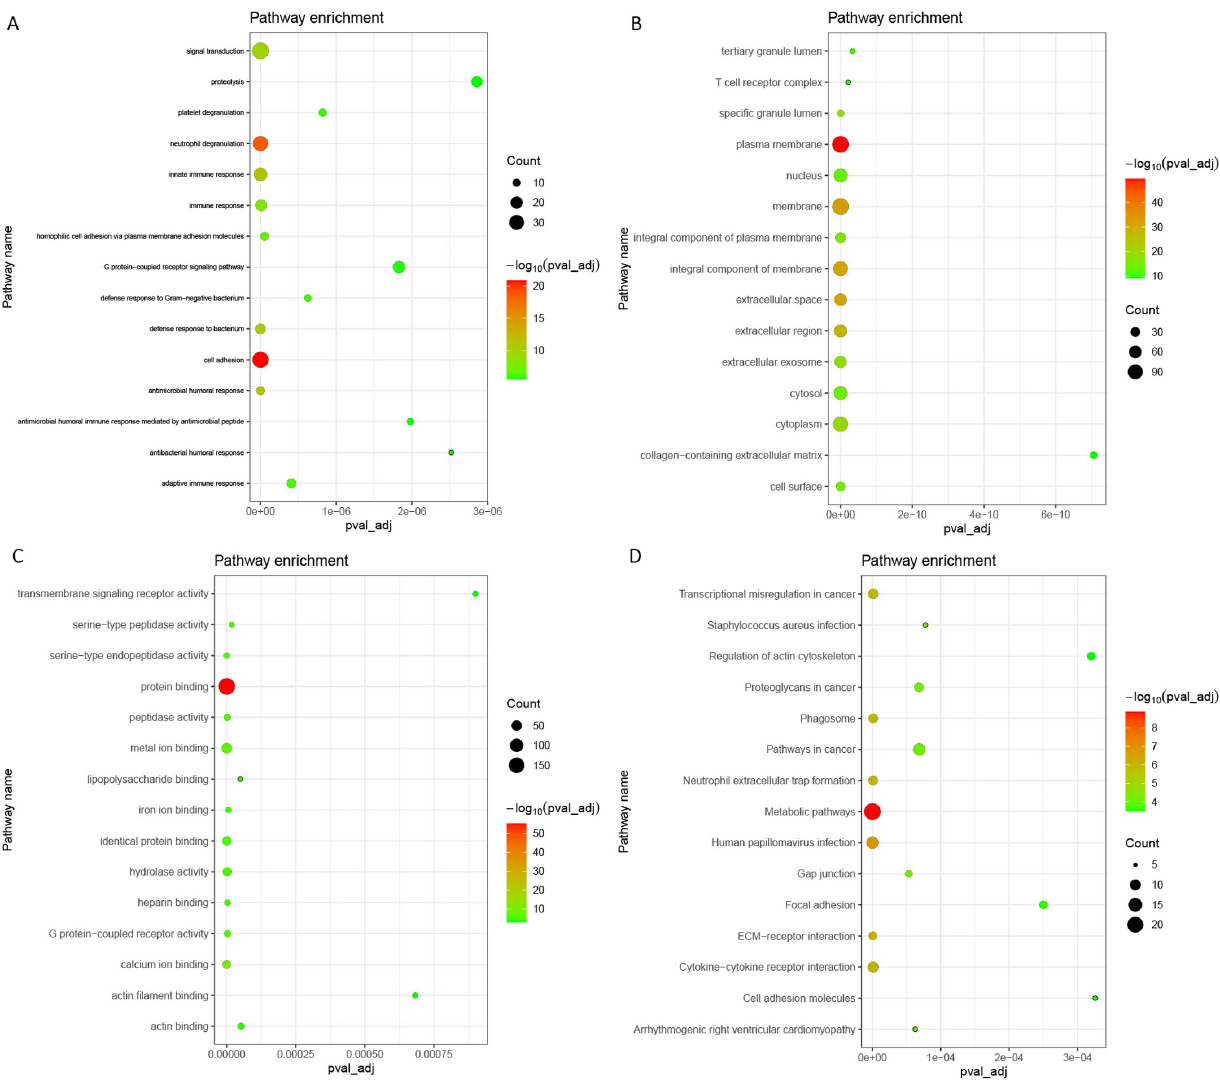
Supplementary Figure 1. Significantly enriched GO terms and KEGG pathways of DEmRNAs co-expressed with DElncRNAs. (A) BP, biological process; (B) CC, cellular component; (C) MF, molecular function; (D) KEGG